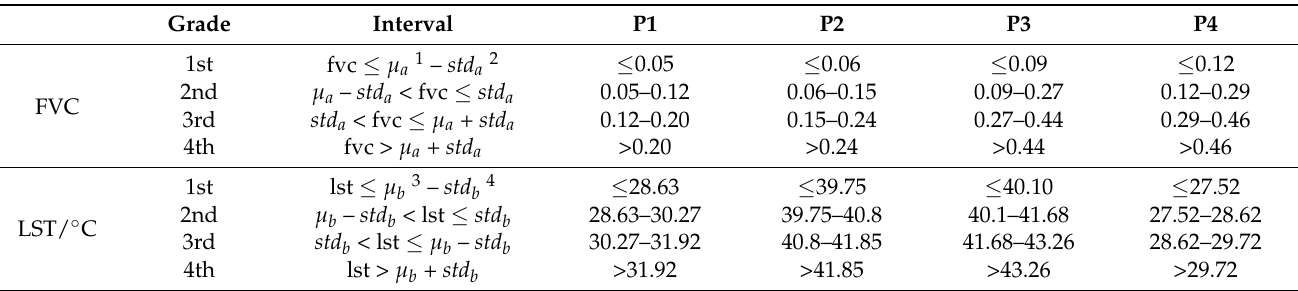
Table 2. Grading of FVC and LST at P1–P4.